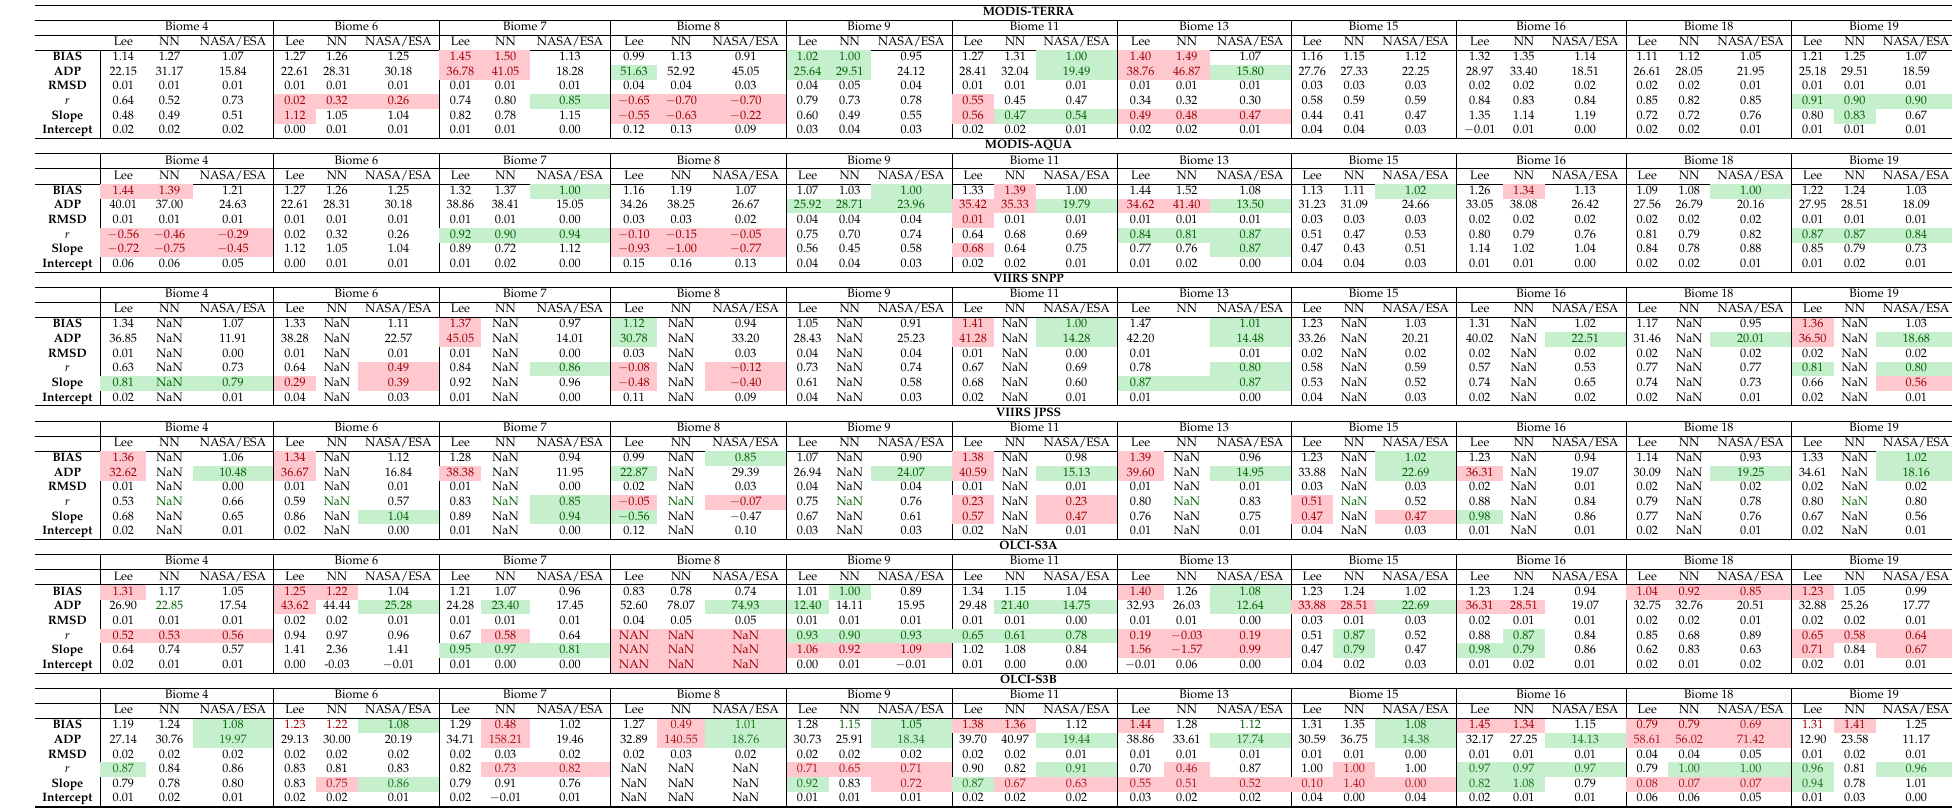
Table A6. Results for each of the biomes for each sensor. Individual results for each of the satellite sensors within each of the biomes, with the red color indicating poor performance for a given satellite sensor and the green good statistical performance for a given sensor within a biome. The NASA empirical algorithm (see Methods section) was applied for the MODIS and the VIIRS sensors, whereas the ESA empirical algorithm was applied to the OLCI sensors. As they are both empirical algorithm, they were grouped together for the overall statistical